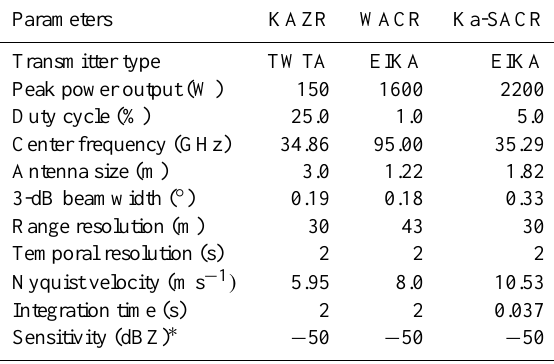
Table 1. Specification of radars used in this study: Ka-band ARM Zenith Radar (KAZR), W-band ARM cloud radar (WACR), Ka-band Scanning Cloud Radar (Ka-SACR). Transmitter types: traveling-wave tube amplifier (TWTA) and extended interaction klystron amplifier